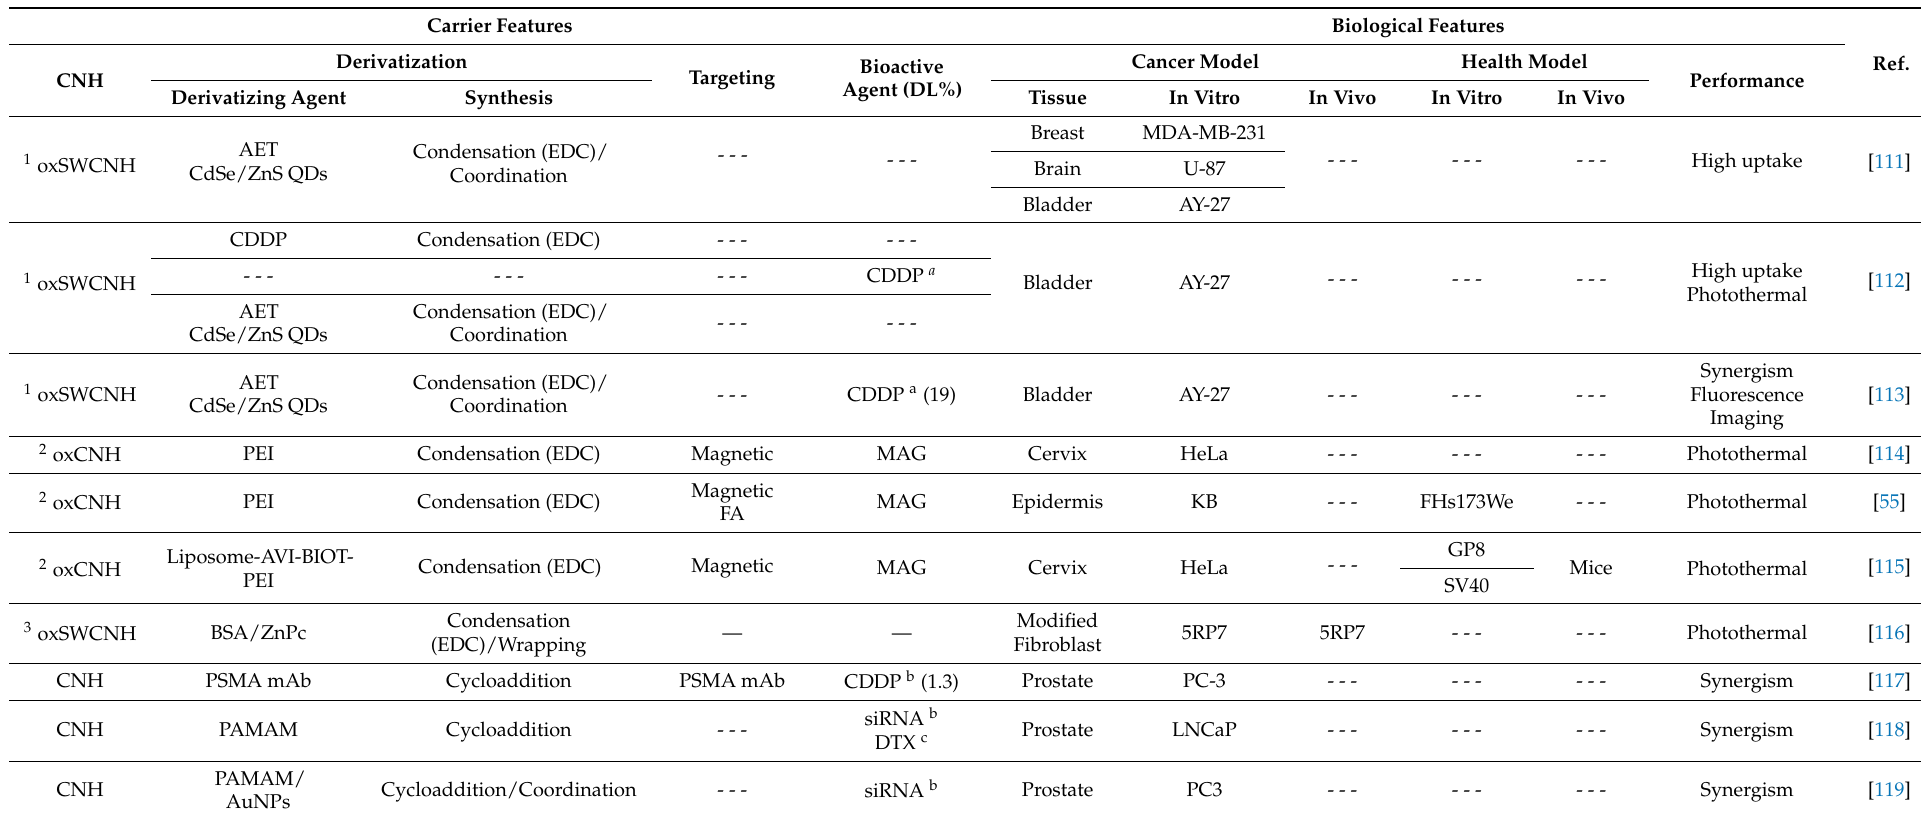
Table 2. Performance of covalent modified CNH for cancer